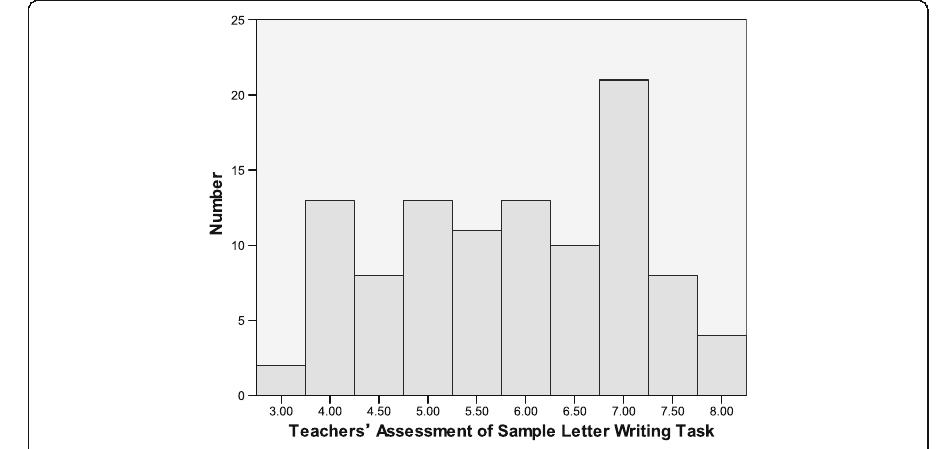
Fig. 4 Teachers ’ assessment of sample letter writing task